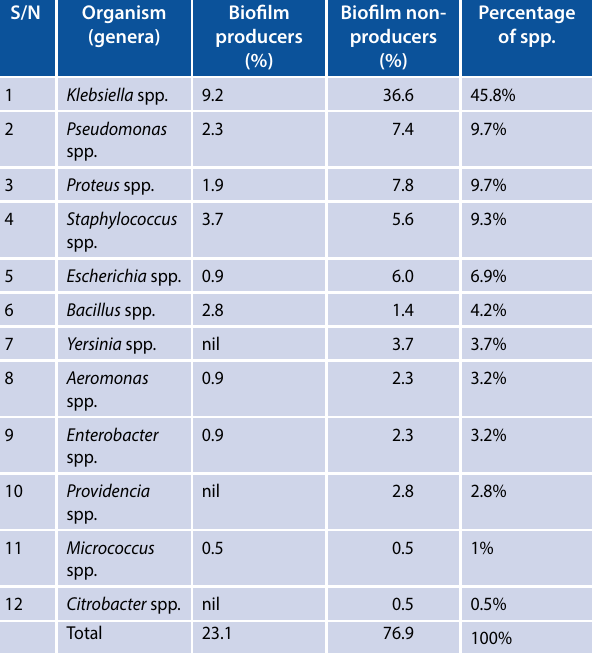
Table 3: Screening of 216 bacterial isolates from the mid-stream urine, catheter-stream urine and catheter tips for biofilm S/N Organism